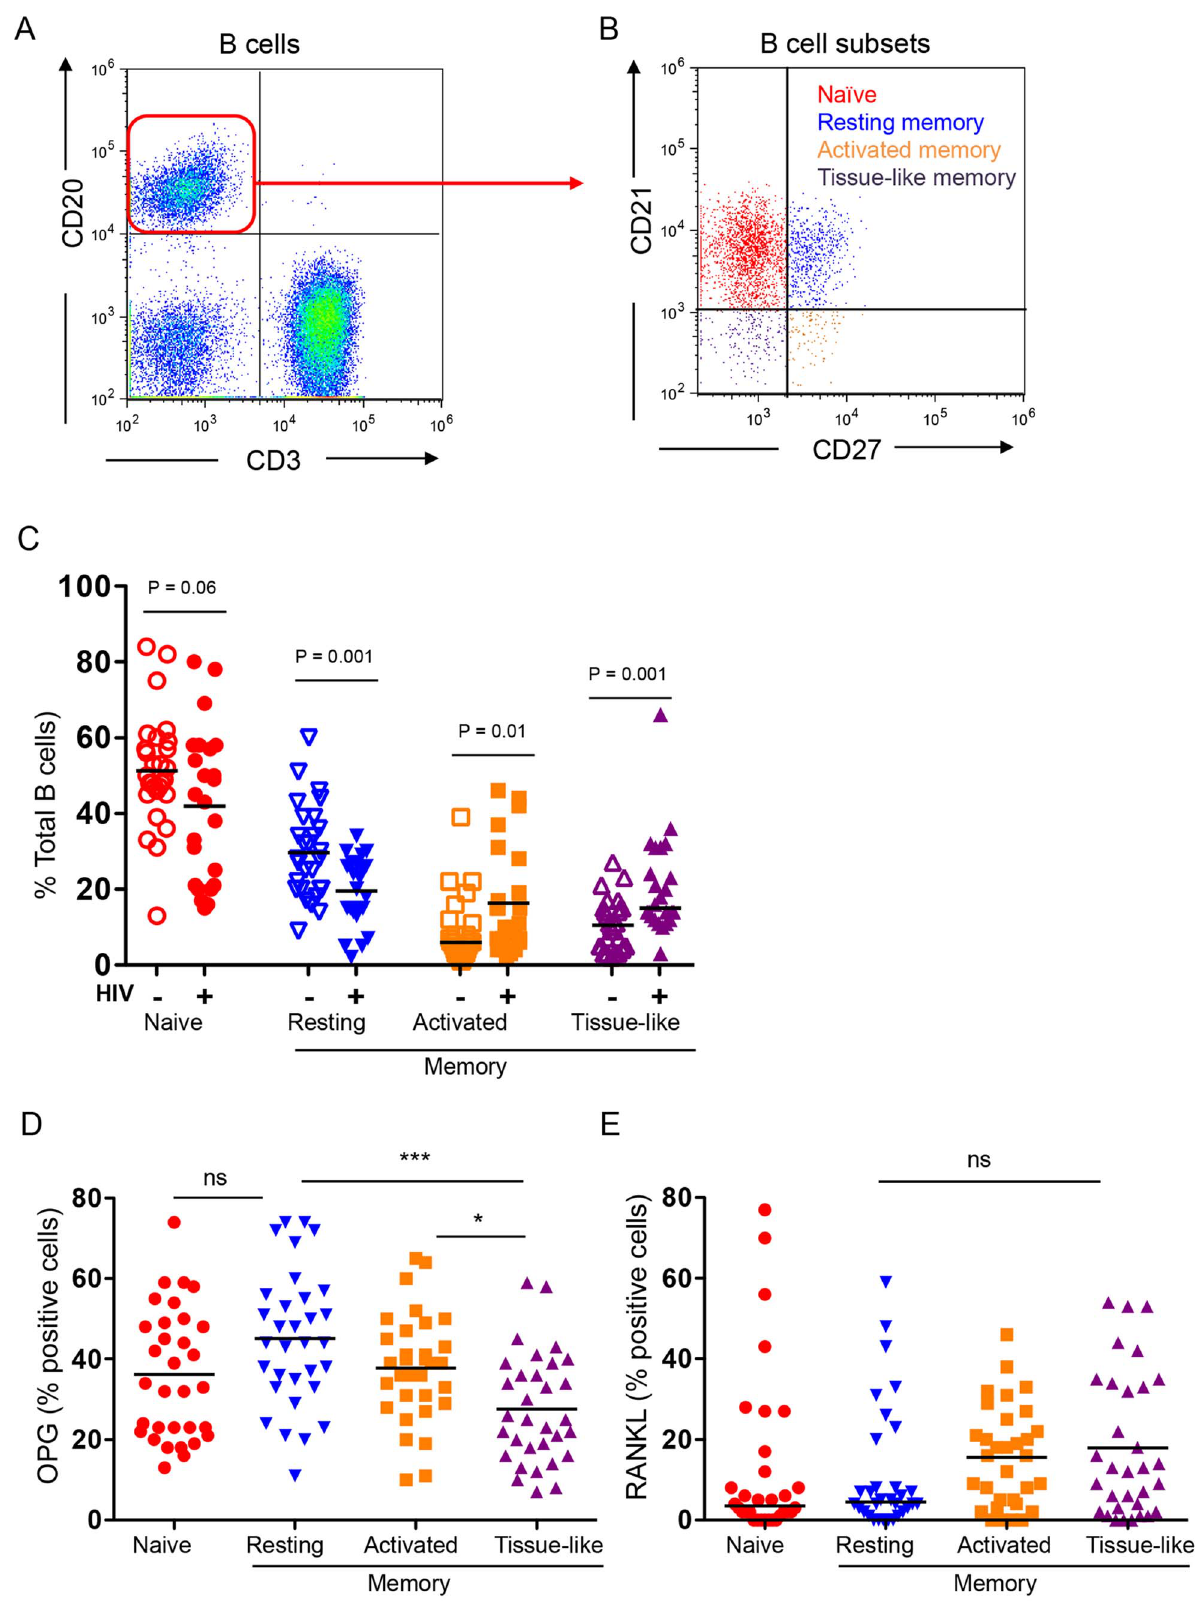
Figure 2. B cell subset RANKL and OPG expression in HIV-negative and HIV-positive individuals. A ) Total B cells (CD3 2 CD20 + cells) were identified in the lymphocyte gate. B ) B cells were further divided into 4 distinct subsets: naı¨ve (CD21 hi CD27 2 ), resting memory (CD21 hi CD27 + ), activated memory (CD21 2 CD27 + ), and exhausted tissue-like memory (CD21 2 CD27 2 ). C ) B cell subset distribution in HIV-negative (N=28) and